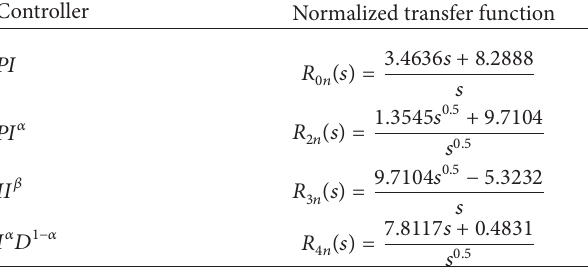
Table 3: Example 1 controllers.